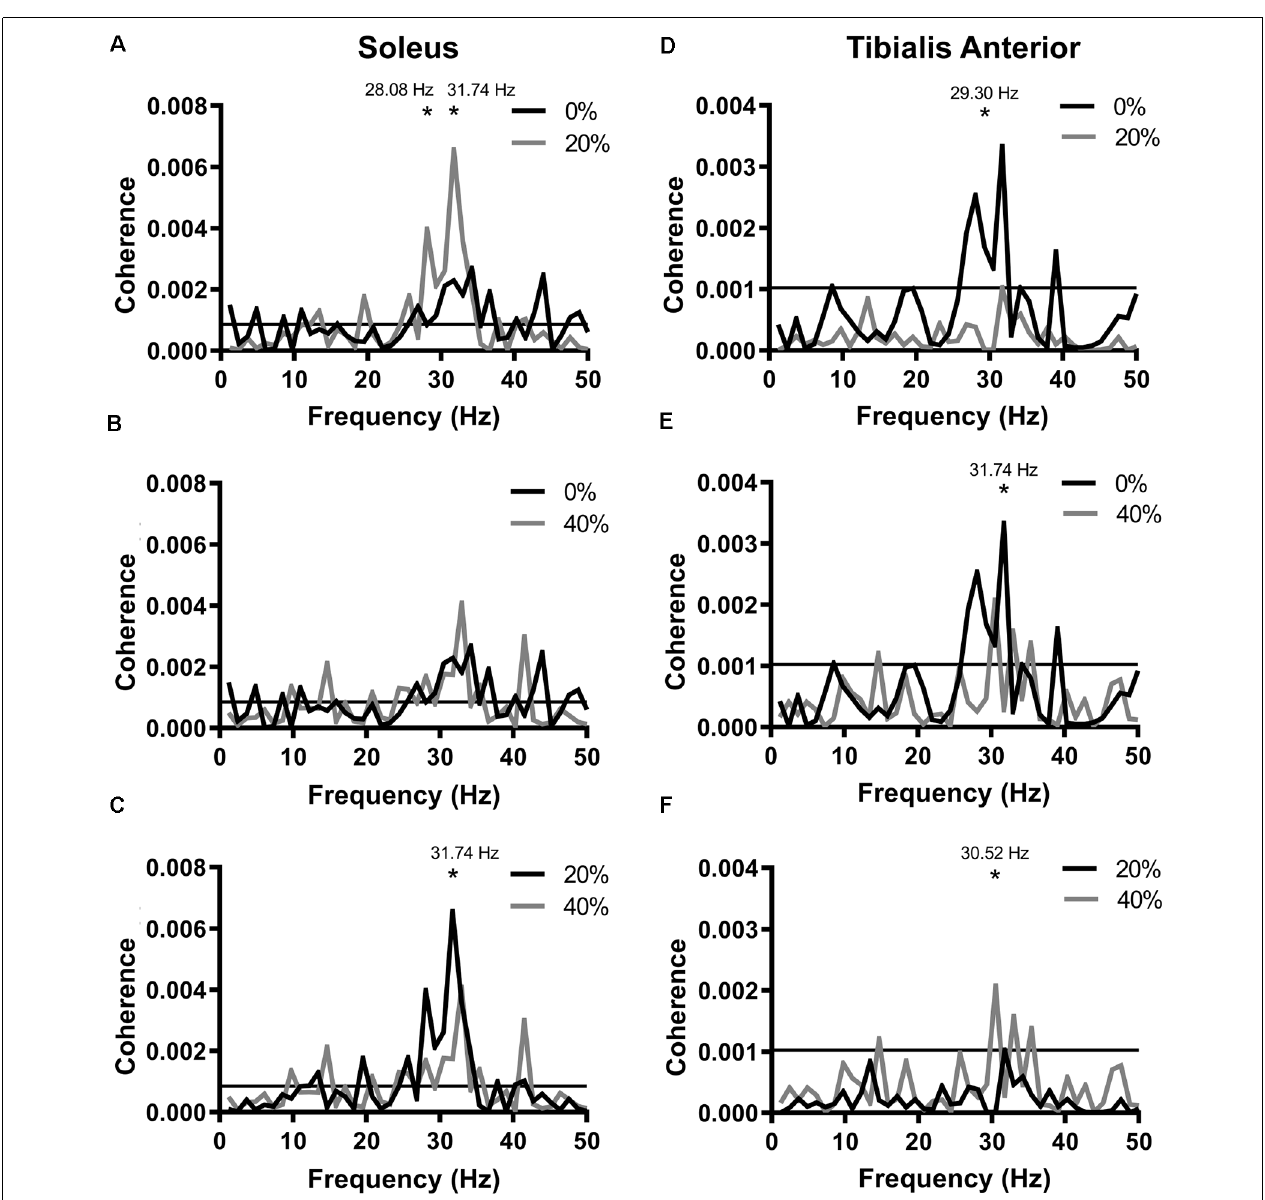
FIGURE 3 | Coherence functions generated between probe acceleration and soleus EMG (A–C) or tibialis anterior EMG (D–F) . Horizontal lines represent the 95% confidence limit bounds. Frequency resolution: 1.2207 Hz. *Indicates significant differences between the two plotted coherence functions at the frequency indicated. The difference in coherence frequency resolution: 1.2207